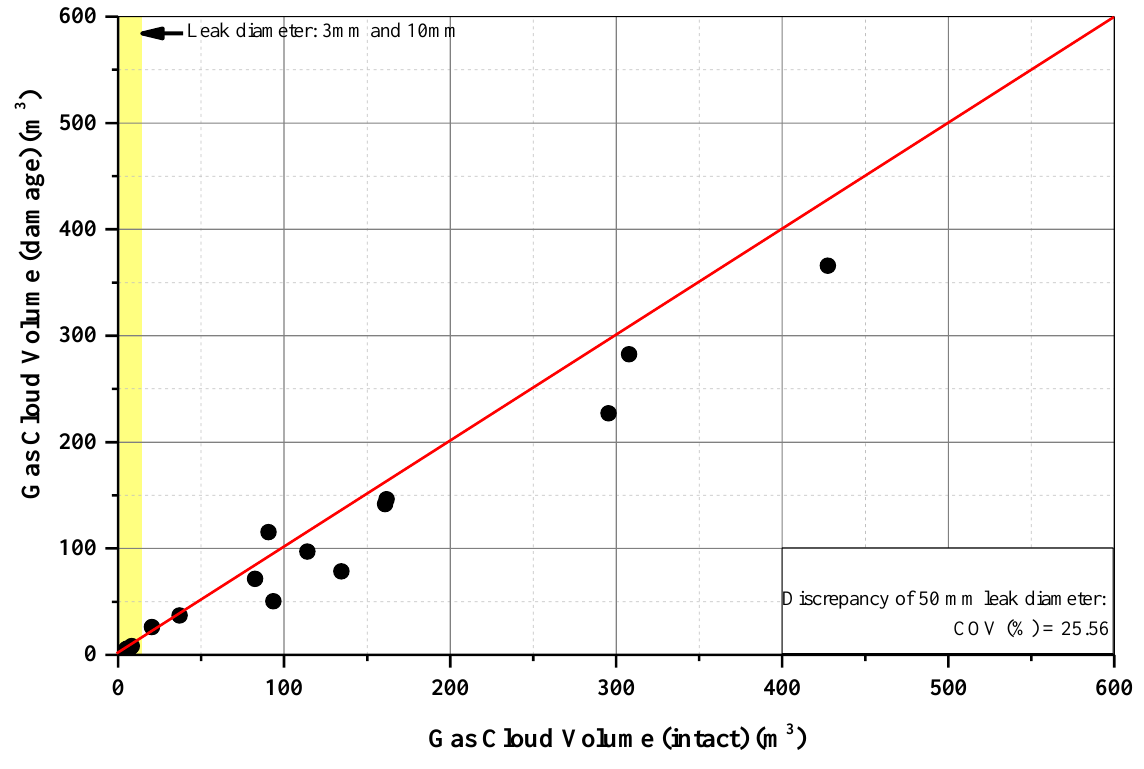
Figure 20. Plot of gas cloud volume.